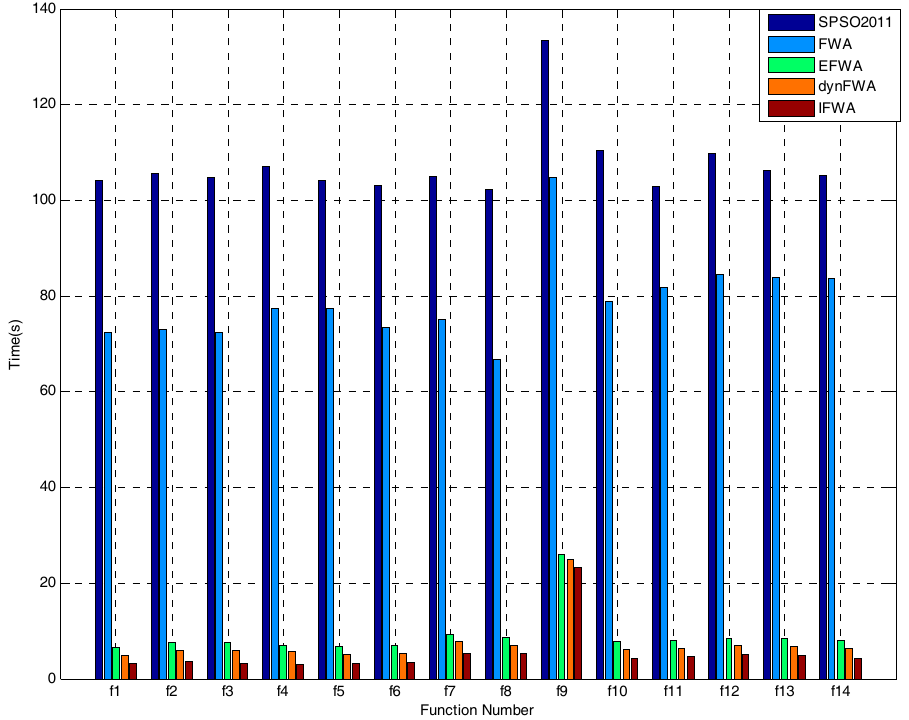
Figure 3. The FWA, EFWA, dynFWA, SPSO2011 and IFWA run-time cost.